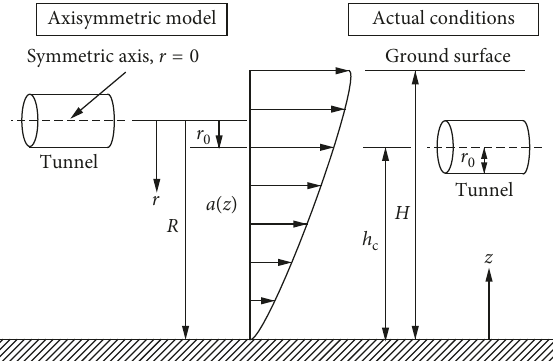
Figure 4: Coordinates of the axisymmetric model in comparison with the coordinates under actual